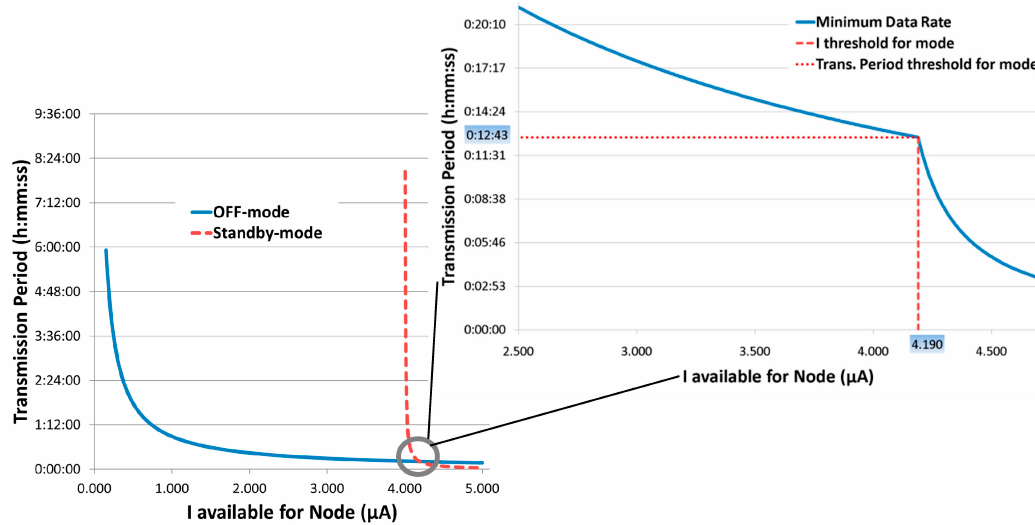
Figure 14. Transmission period vs. Extracted currents in different operating modes.